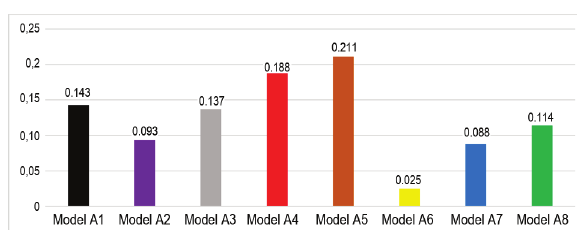
Fig. 12. Comparison chart of weights of eight laminated glass models in AHP